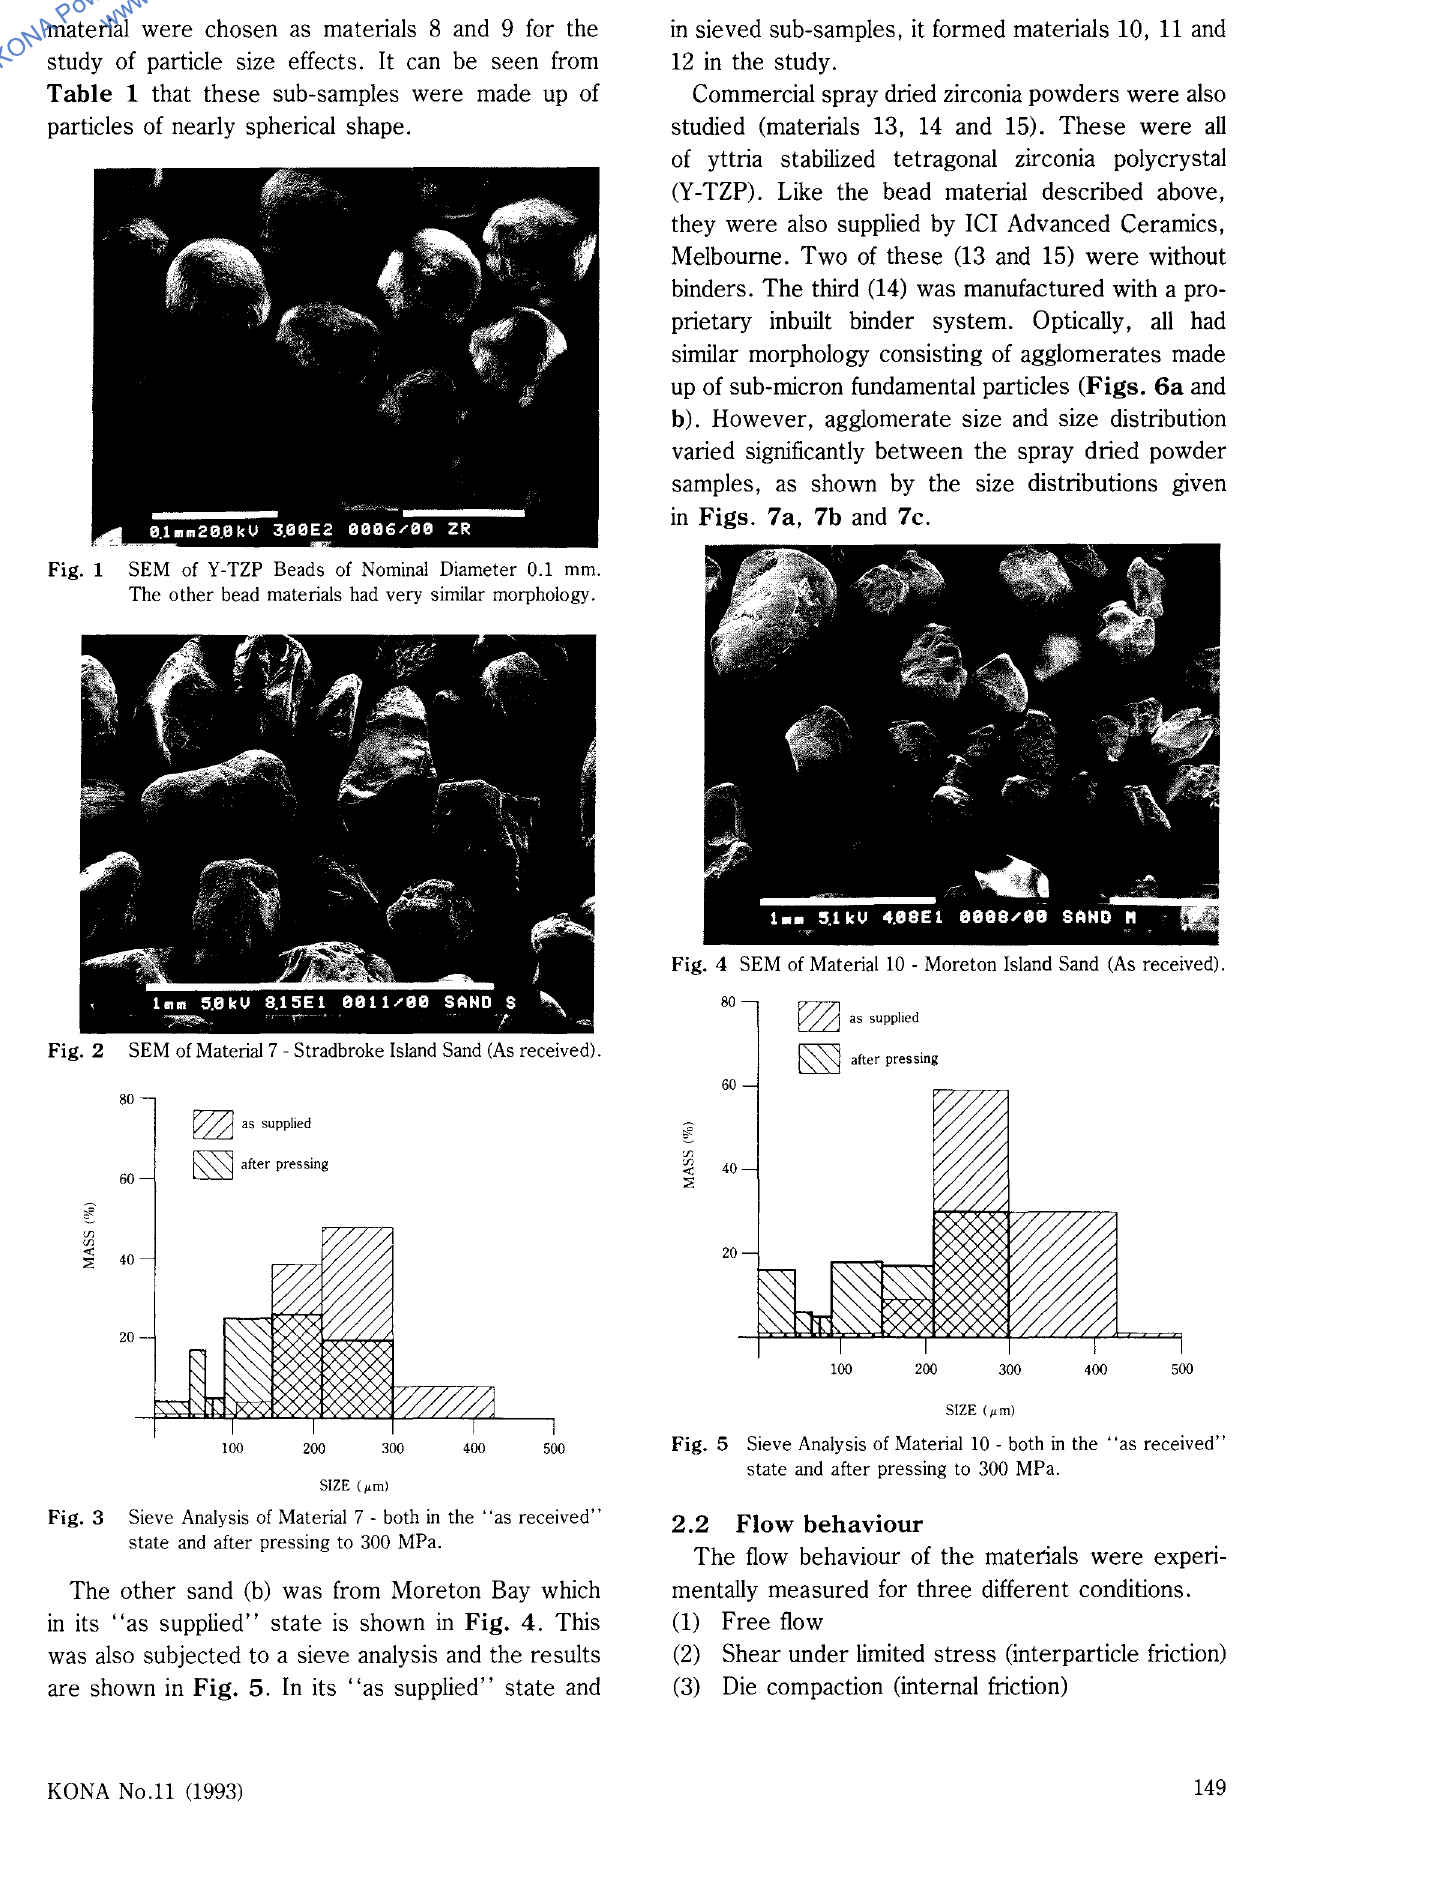
Fig. 5 Sieve Analysis of Material 10 - both in the "as received" state and after pressing to 300